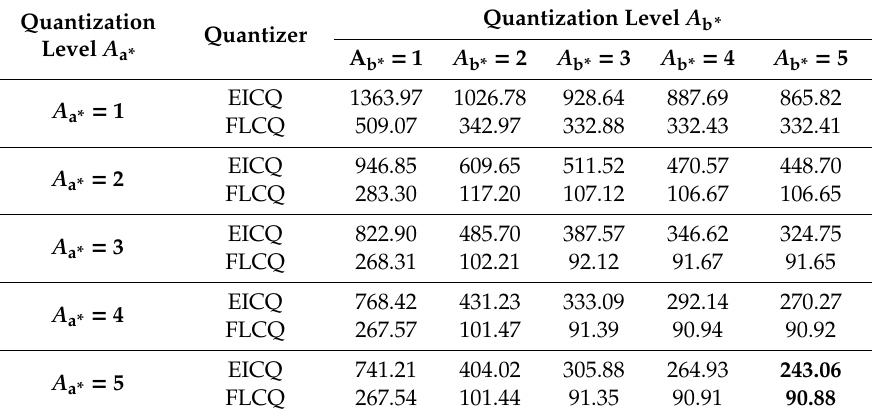
Table A6. The mean square error of the EICQ and FLCQ quantizers on Corel-1000.